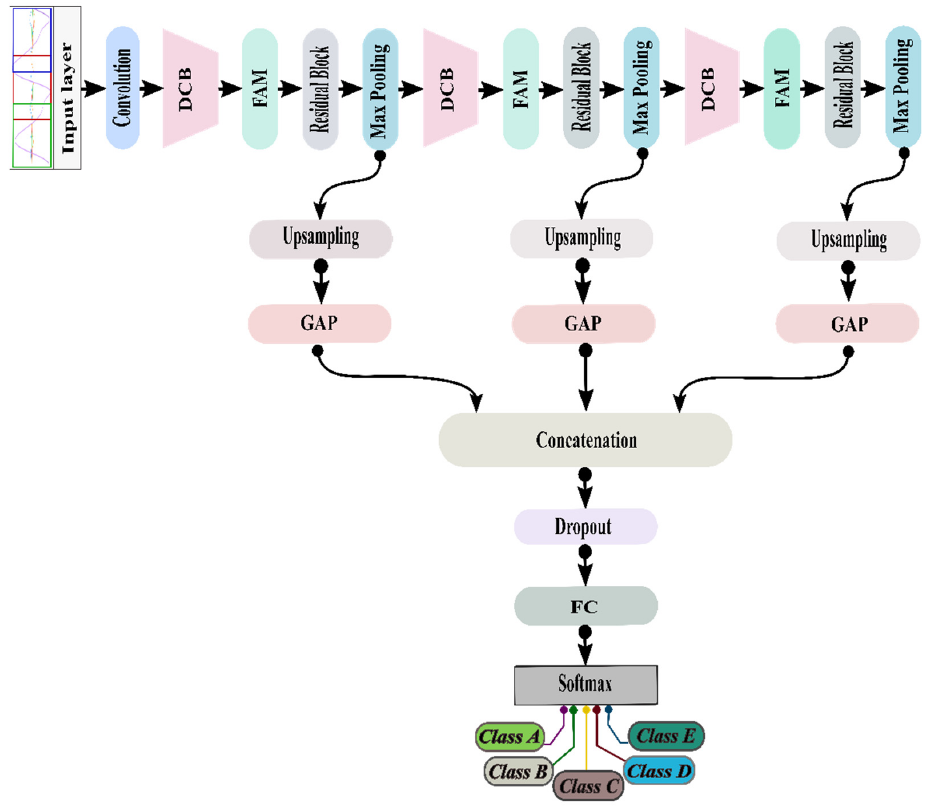
Figure 3. The architecture of our proposed model (Epileptic-Net).